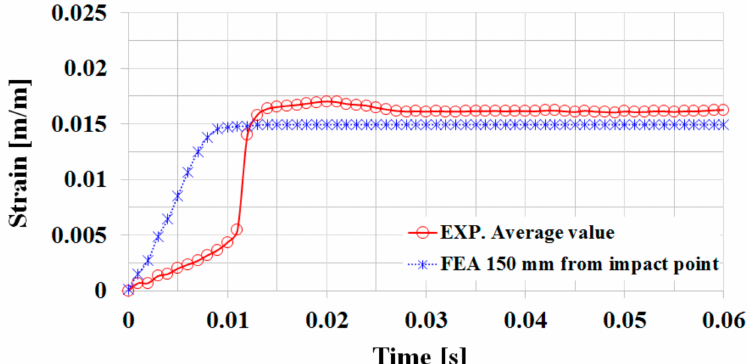
Figure 21. Strain comparison (drop height of 3 m).